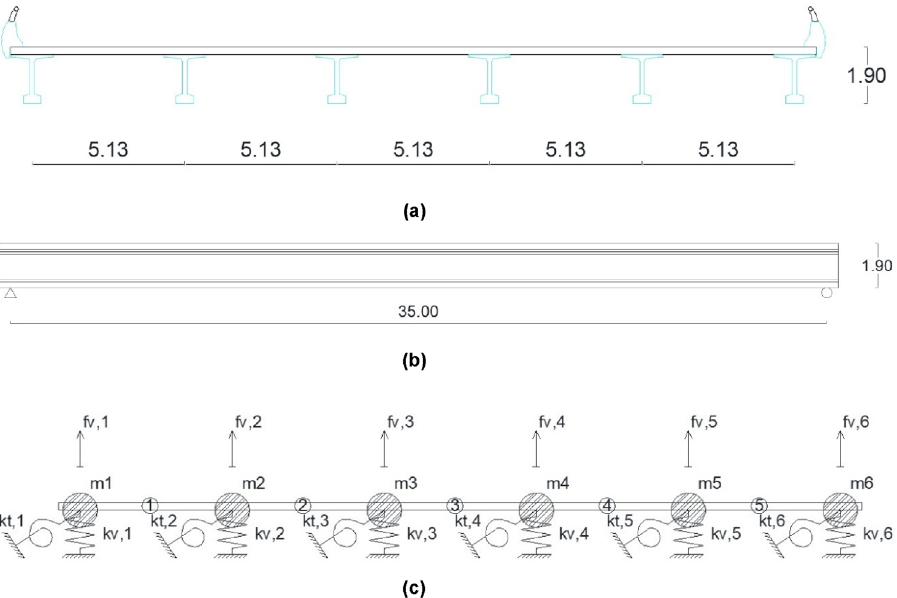
Figure 4. Structural model of a girder bridge with six longitudinal girders: ( a ) cross-section; ( b ) longitudinal profile; ( c ) proposed structural